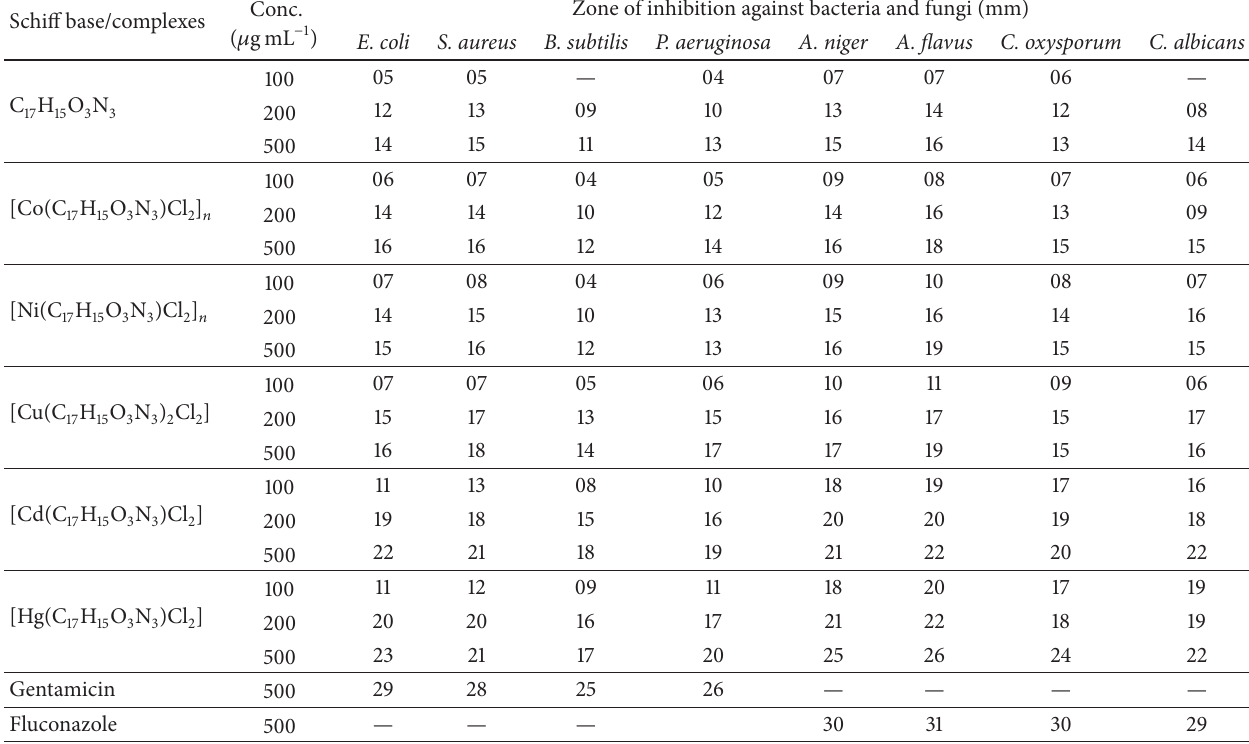
Table 5: Antimicrobial activity results of the Schiff base and its metal complexes (MIC). Conc. Schiff base/complexes